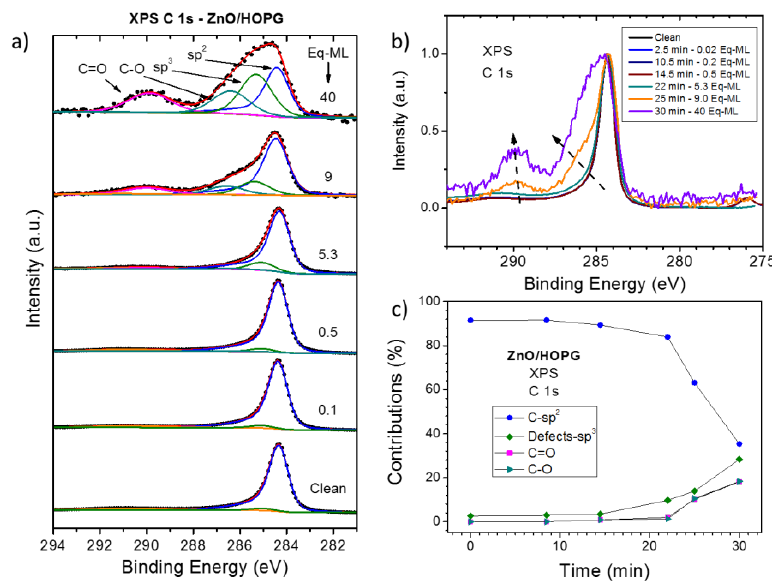
Figure 3. ( a ) XPS C 1 s fitted spectra as a function of the coverage for the growth of ZnO on HOPG; ( b ) normalized XPS C 1 s spectra as a function of the coverage and deposition time; ( c ) relative intensities of the C 1 s spectra fitting components as a function of deposition time.